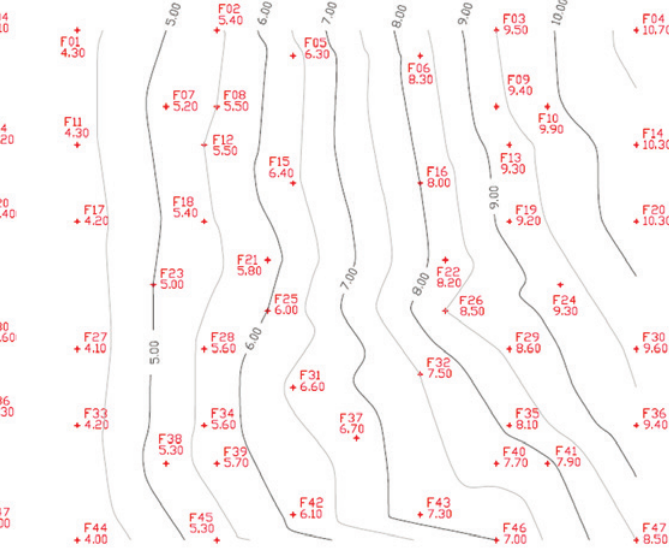
Figura 13 Curva de isorecalque do modelo CASCA